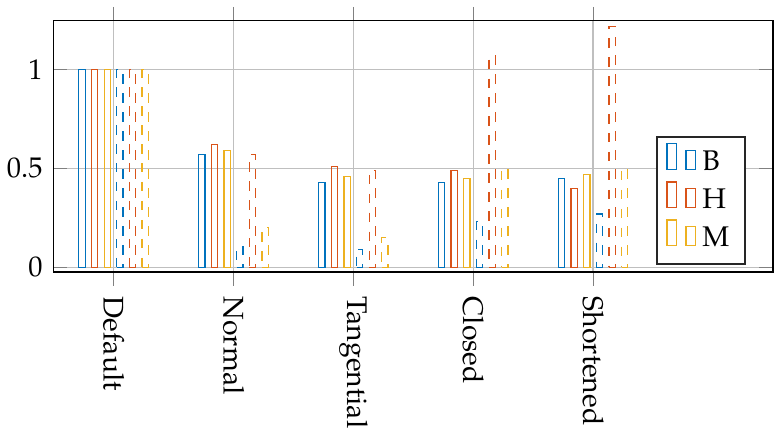
Figure 10. No-load fractional dependency of the inclination angles due to changed pole shoe design